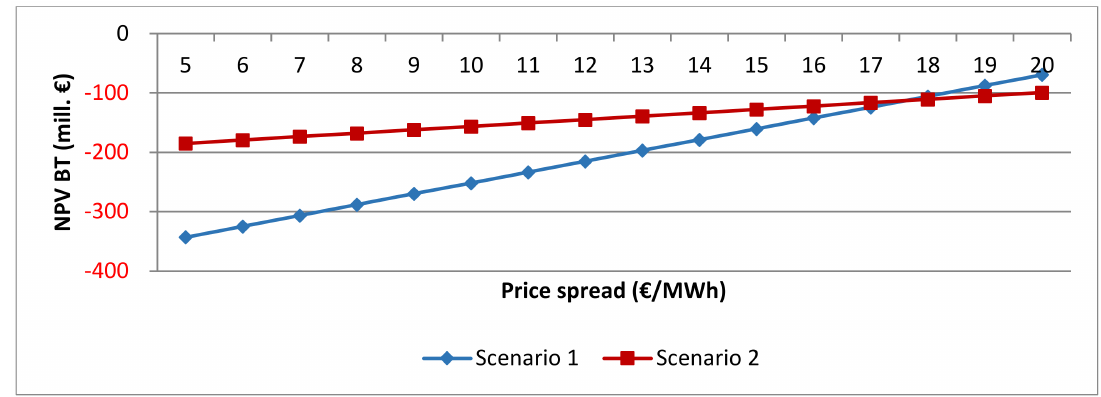
Figure 13. Net present value before tax as a function of price spread, Scen. 1 and 2, incl. flooding time.